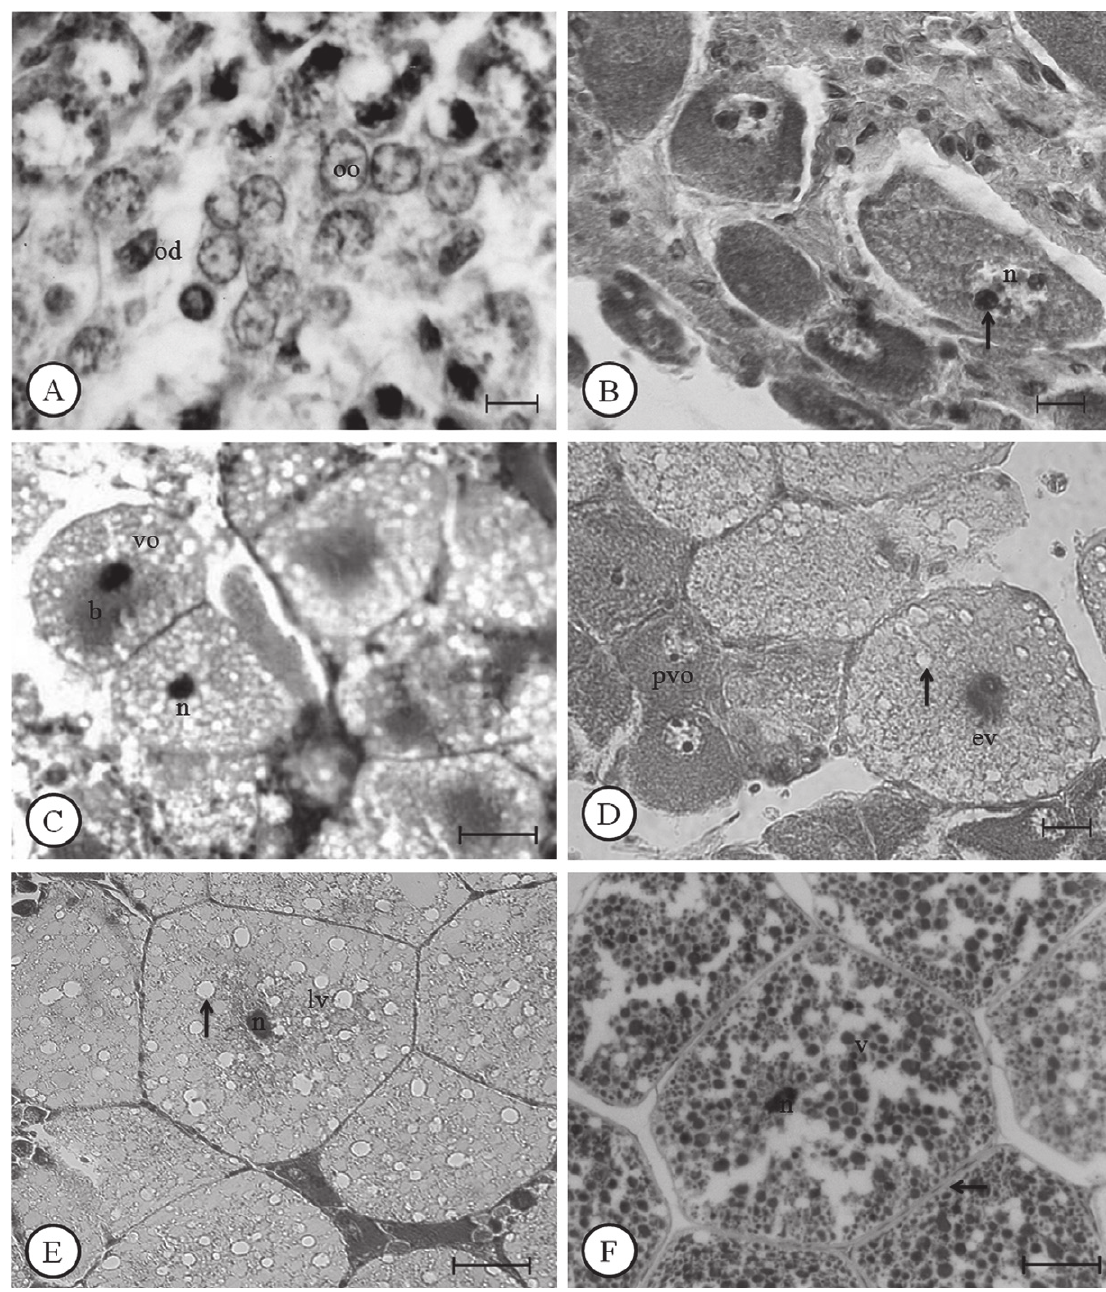
Fig . 3. – Photomicrograph of the germinative cells of Goniopsis cruentata stained with Gomori’s trichrome showing germ cells at different development stages. a, oogonia (oo). observe compacted chromatin, indicating possible cell division (od). scale: 10 µm. b, previtellogenic oocytes (pvo); nucleus (n); peripheral nucleoli (arrow). scale: 15 µm. C, oocytes in vitellogenesis (vo). basophilic region (b) near the nucleus (n). scale: 100 µm. d, oocyte in early-stage vitellogenesis (ev); vitelline vesicles (arrow). Previtellogenic oocytes (pvo). scale: 25 µm. e, oocyte in late-stage vitellogenesis (lv). nucleus (n). scale: 50 µm. F, oocyte in late-stage vitellogenesis. Light green chorion (arrow). nucleus (n). scale: 60